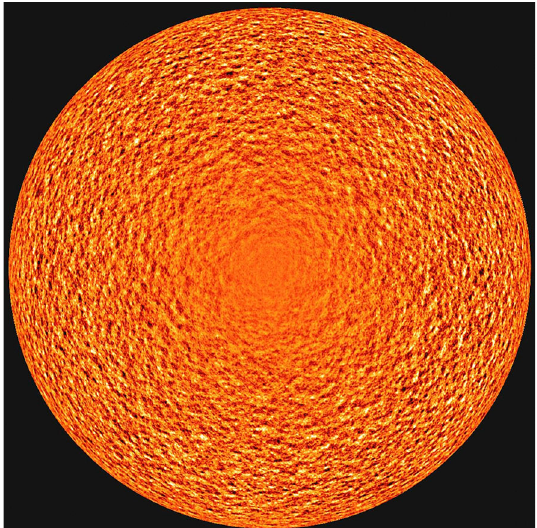
Fig. 1 The supergranulation pattern as revealed by Doppler imaging of the full solar disc obtained with the MDI instrument onboard the SOHO satellite. Image credits: